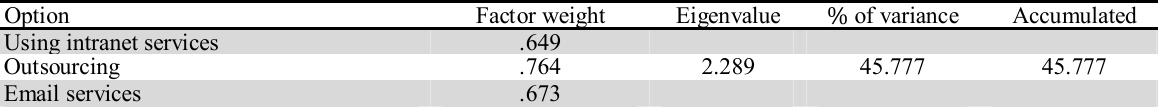
The summary of factors influencing service strategy